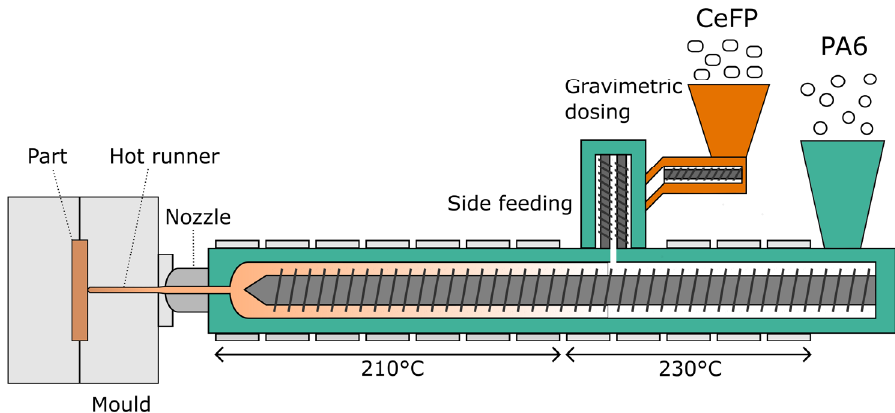
Figure 1. Schematic representation of low-temperature fibre direct compounding of cellulose fibre